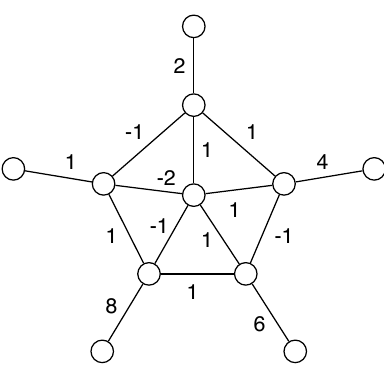
-antimagic labeling of H k